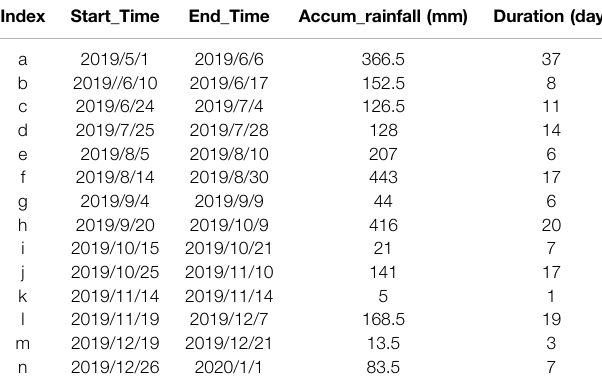
TABLE 1 | Classi fi cations of the rainfall events. The two events in red were selected for the case